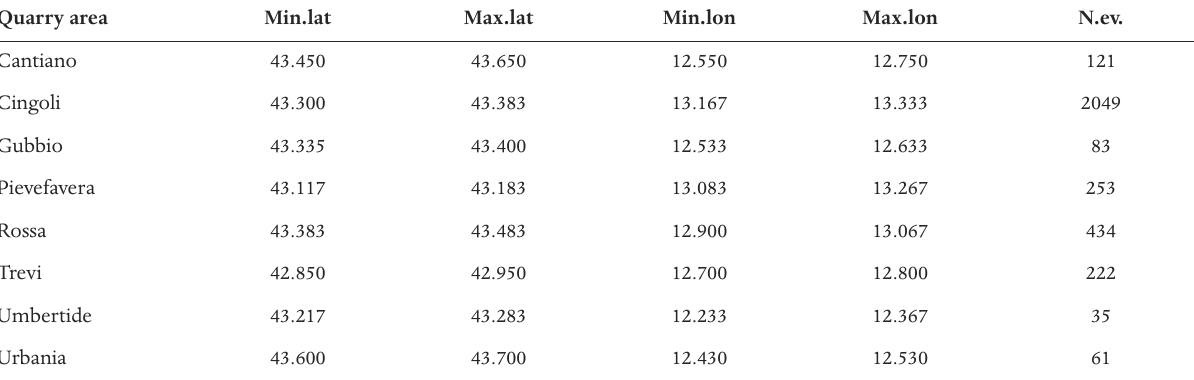
Table 1. Quarry areas identified in this work. Coordinates are reported in fractional degrees of latitude and longitude. Last column: num- ber of events assigned to each